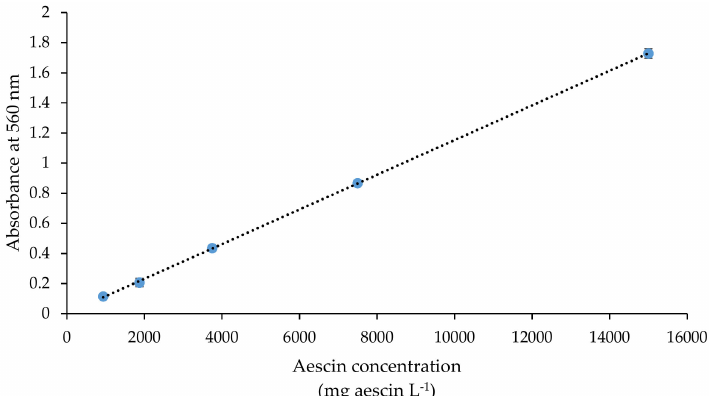
Figure 3. Standard curve for aescin using the modified vanillin-sulphuric acid method (Y = 0.00012X + 0.0008 ( R 2 = 0.9999)).